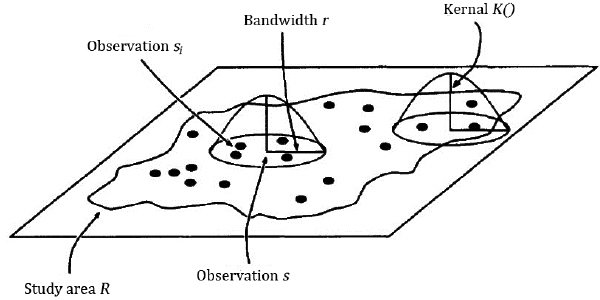
Figure 3. Kernel density estimate for points in plane.